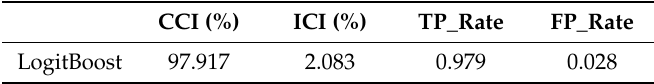
Table 4. Accuracy of the LogitBoost